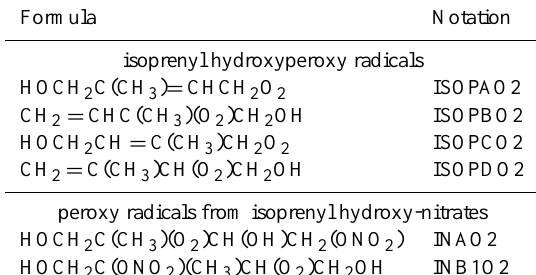
Table 2. Isoprene-derived intermediates discussed in the